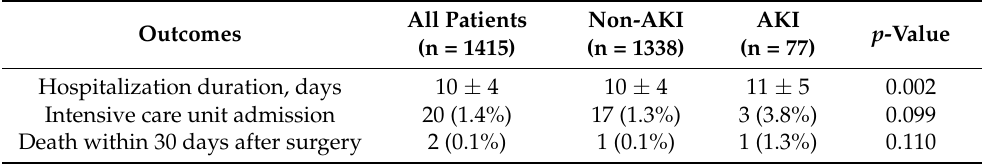
All Patients Non-AKI (n = 1415)